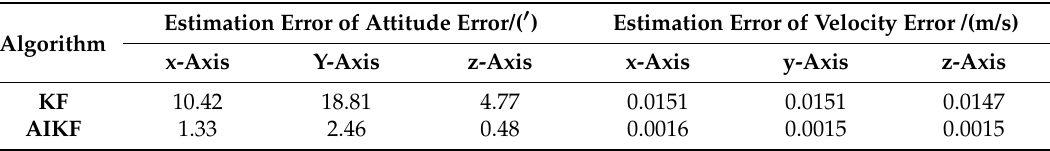
Table 4. Main functional specification of MEMS